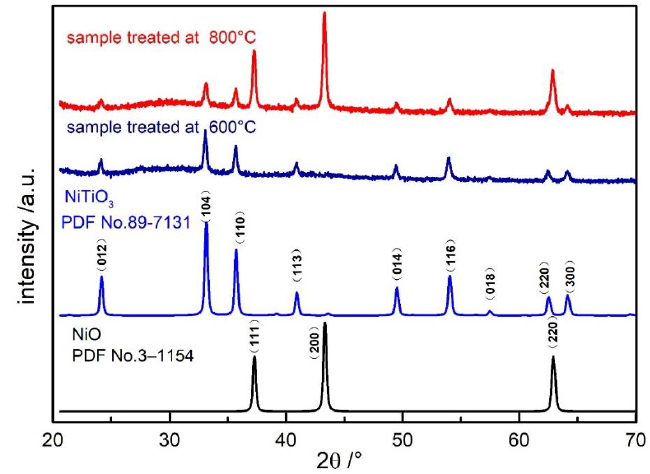
Figure 1. XRD patterns of NiO(10%)/NiTiO 3 composite nanofibers calcined at different